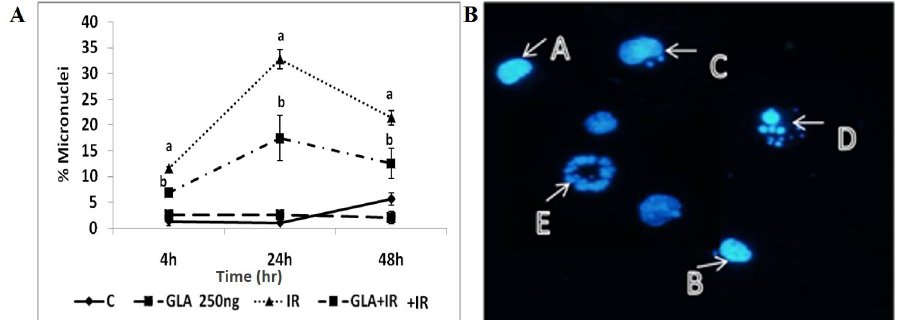
Figure 5. Estimation of DNA damage in RAW 264.7 cells through micronuclei estimation using DAPI ( A ). Values (n = 6) expressed as mean ± SEM. Significance ( p <0.01) represented by a , b when compared with control and irradiation, respectively. C, control; GLA, gamma-linolenic acid; IR, irradiation (2 Gy). Pictorial representation of RAW 264.7 cells stained with DAPI under fluorescence microscope ( B ), with nucleus visible at 100× resolution. A. normal nucleus, B. nucleus with single micronucleus, C. nucleus with two micronuclei, D. nucleus with multiple micronuclei, and E. nucleus of apoptotic cell.